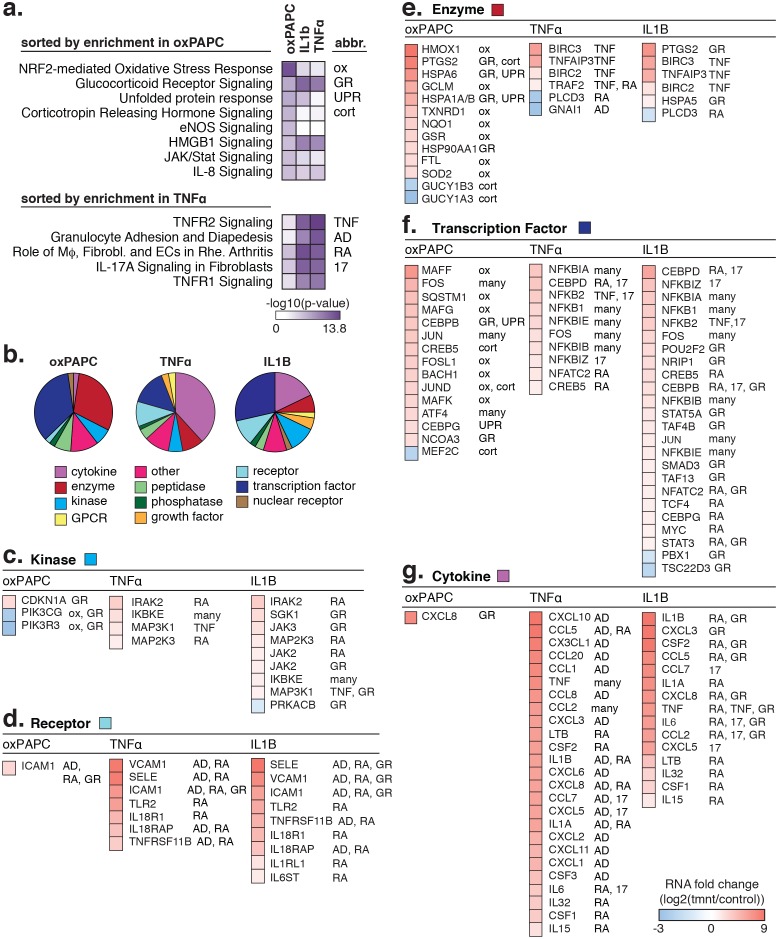
The transcriptional response to oxPAPC, TNFα, and IL1β.(a) Enriched pathways for genes regulated after 4-hr treatment with 40 µg/ml oxPAPC, 10 ng/ml IL1β, and 2 ng/ml TNFα are shown. (b) The proportion of molecule types regulated per cell treatment. (c–g) The direction and degree of gene regulation is shown by heatmap for genes in the top four enriched pathways (from a). These include d-receptors, e-enzymes, f-transcription factors, and g-cytokines.